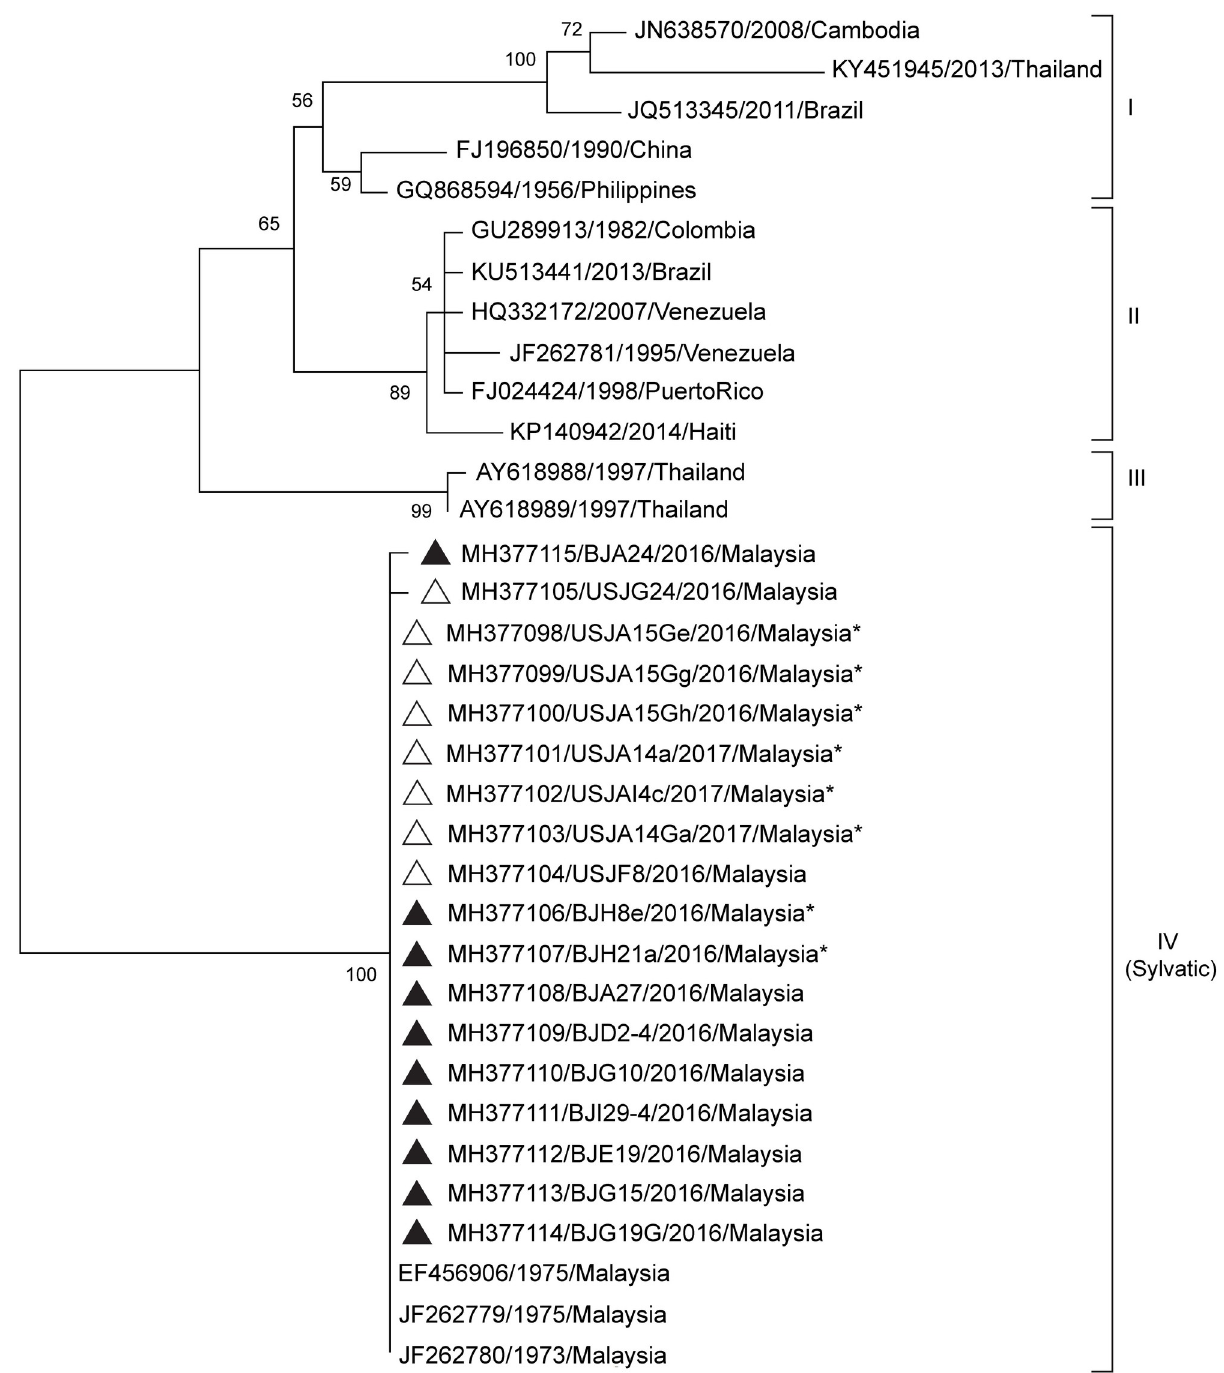
Fig 4. Phylogenetic analysis of the CprM gene sequences of DENV-4 isolates from the Klang Valley. Sample sequences of DENV-4 (351 nt) from Ae . aegypti (indicated with an asterisk � ) and Ae . albopictus collected from Selangor (indicated with a white triangle) and Kuala Lumpur (indicated with a black triangle) in this study are labelled with the GenBank accession number, sample ID and year of collection. Bootstrap values (1,000 replicates) are shown next to the branches. Taxa of reference sequences are labelled as the GenBank accession numbers, year and country of sample collection.